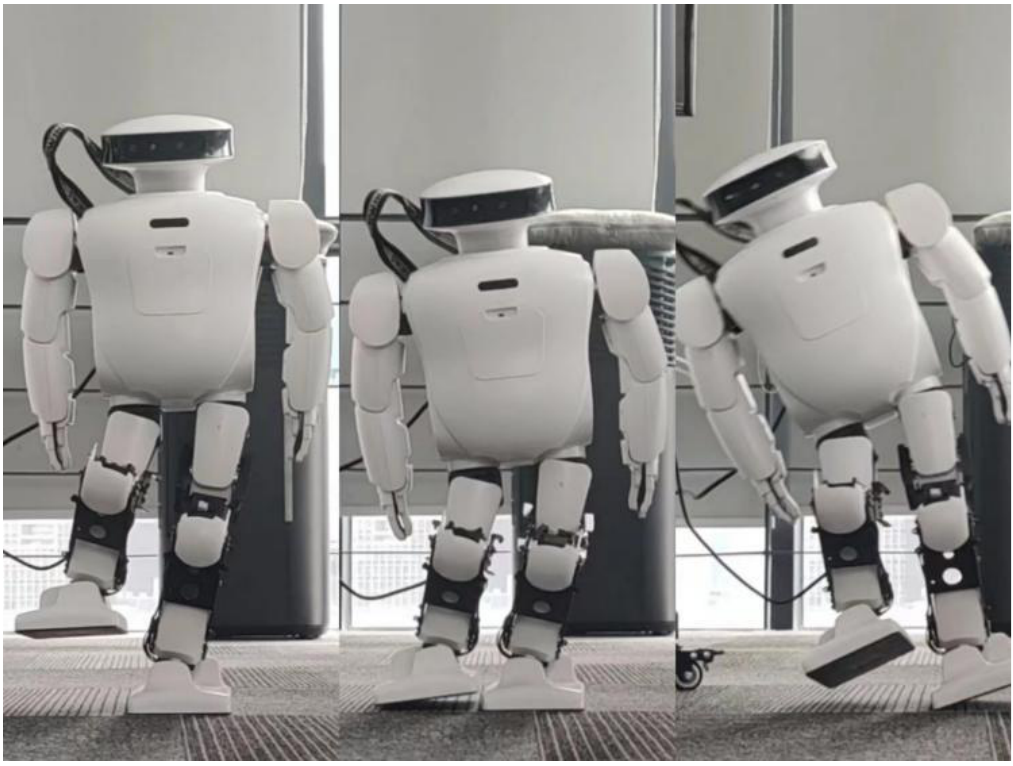
Figure 22. The robot fell down while performing a deeper squat.